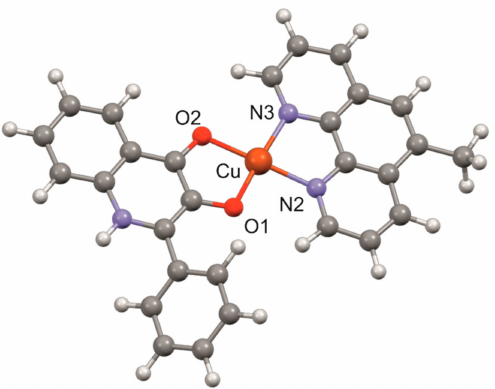
Figure 2. The geometry of the [Cu(mphen)(qui)] + complex cation optimised at the (cid:36) B97X- D/LACVP** level of theory. Table 2. A comparison of the selected interatomic parameters (in Å, ◦ ) within the [Cu(mphen)(qui)] + complex cation obtained using DFT calculations at different levels of theory with those determined using a single crystal X-ray analysis of [Cu(phen)(qui)]NO 3 *. BP (cid:36)